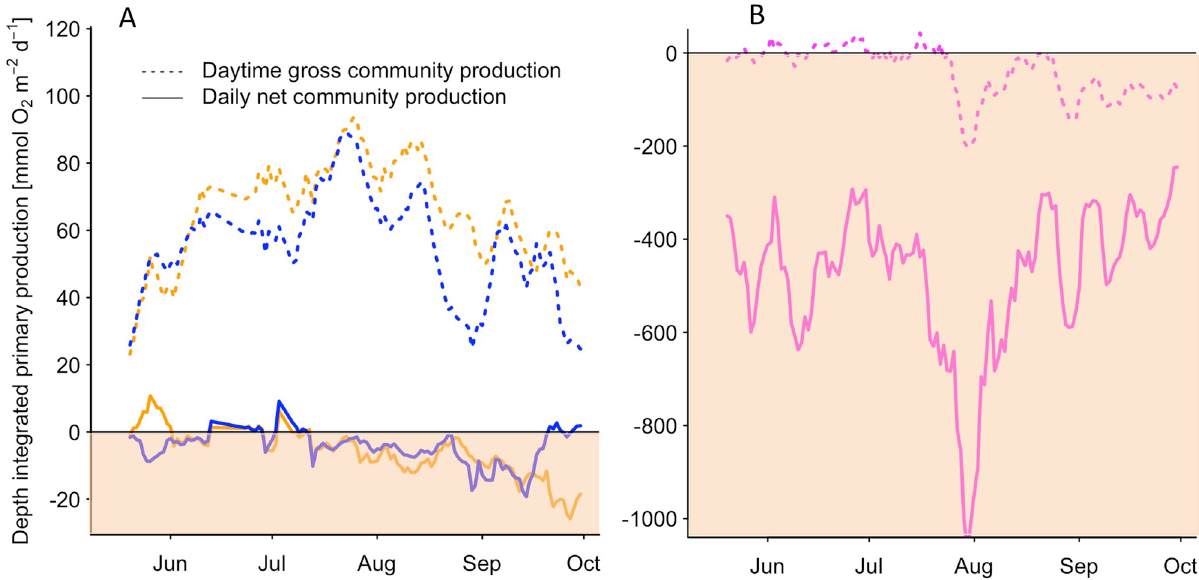
Fig 4. A–Depth-integrated daily net community production (mmol O 2 m -2 d -1 ), the sum of daytime production and night time respiration, and daytime gross community production (mmol O 2 m -2 d -1 ), calculated as the integrated sum of net daytime production and a daytime respiration demand, in macrophyte mesocosms (blue), and phytoplankton mesocosms (orange). The heterotroph region (mmol O 2 m -2 d -1 < 0) is shaded orange. Daytime respiration was calculated from the average night time respiration rate of the respective system and multiplied by the hours of daylight. Dates of cleaning and sampling including the following day were removed prior the analysis. Weekly running mean of daily values are shown. B Depth- integrated daily net community production and daytime gross community production in the Zingster Strom (magenta) calculated as stated above. Please note the different